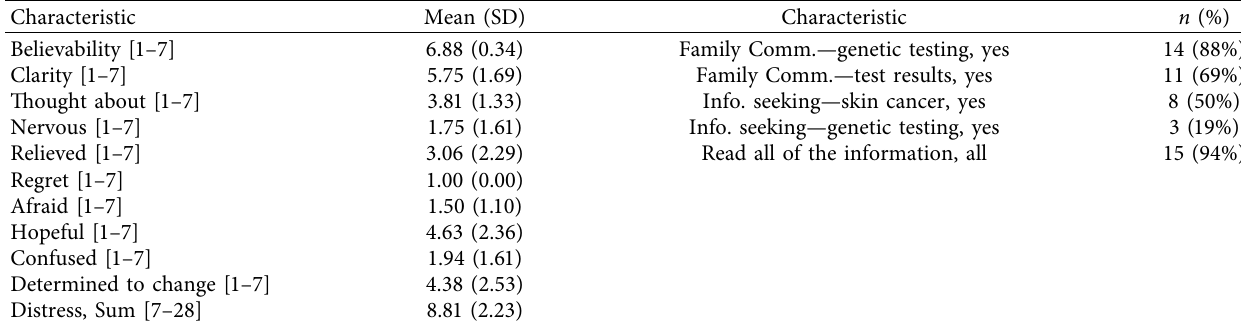
Table 2: Comprehension, distress, and communication outcomes two weeks after risk feedback receipt ( n �